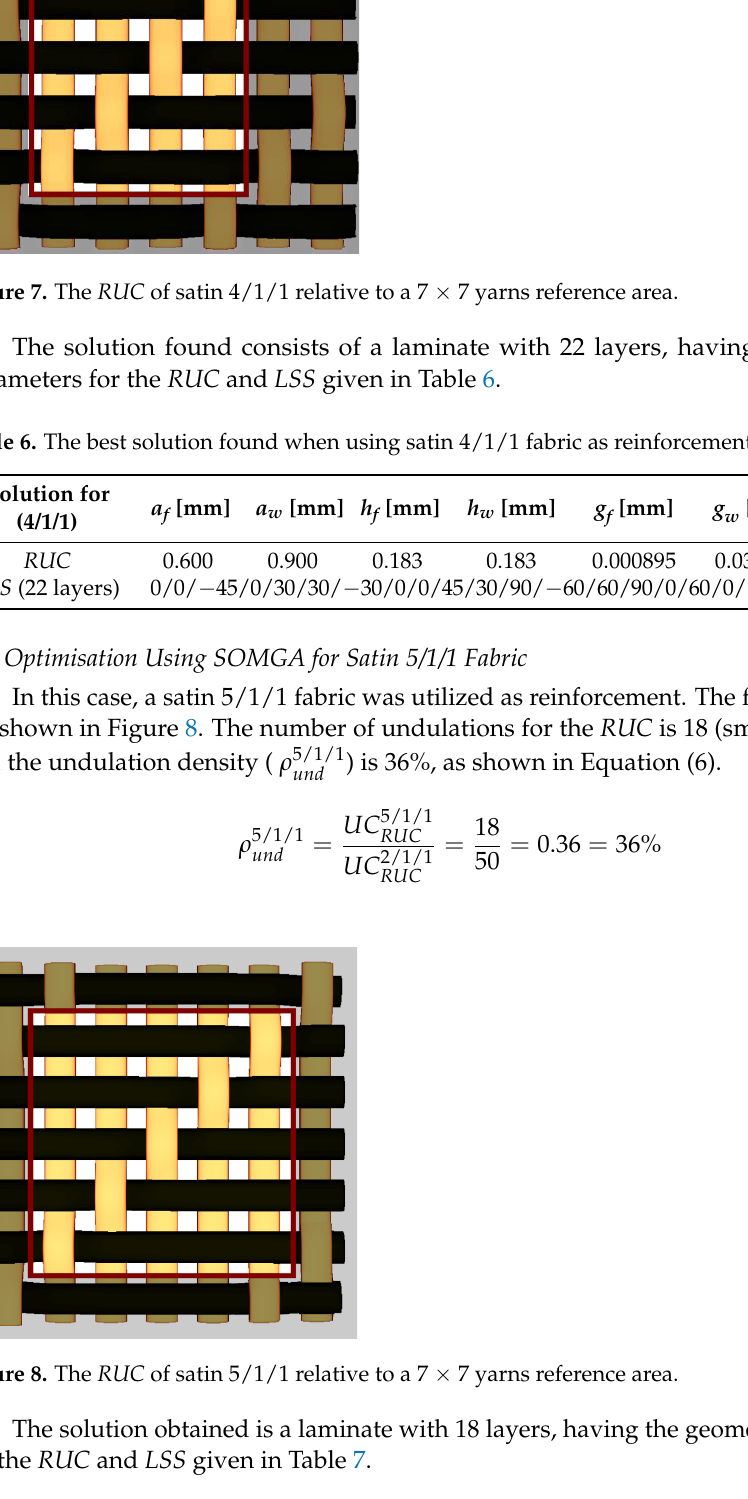
Table 7. The best solution found with satin 5/1/1 fabric as reinforcement.